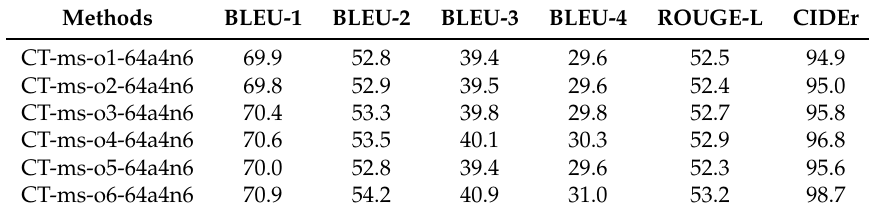
Table 2. The results of the Multi-Level Supervision method with different super parameters.